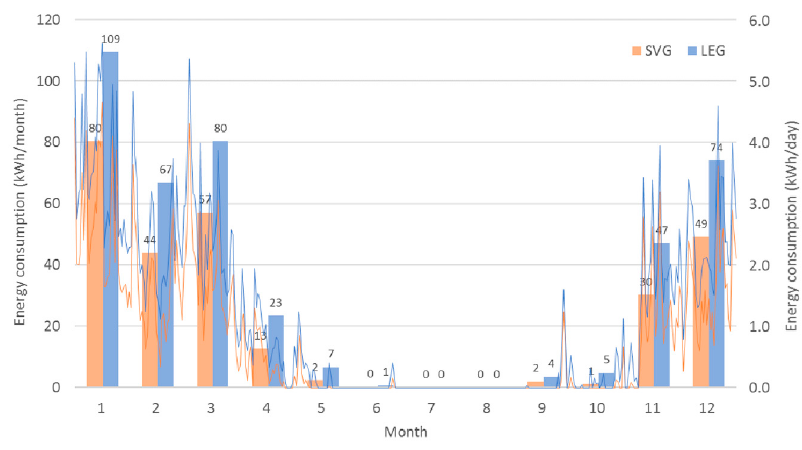
Figure 11. Calculated heating energy consumption of the SVG and LEG.